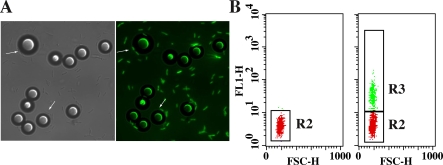
Bacterial Adhesion in Colloidal Suspension(A) Microscope images of MG1655gfp E. coli cells and particles brought into contact with particles in M63B1 medium for 20 min. Bright-field and bright-field fluorescence combined images are shown. Adhesive events can be observed on the combined image; examples are indicated by white arrows.(B) Corresponding fluorescence dot plots are shown for particles alone (left) and cells and particles brought into contact for 20 min (right). Gate R2 corresponds to bare particles, whereas gate R3 corresponds to colonized particles.